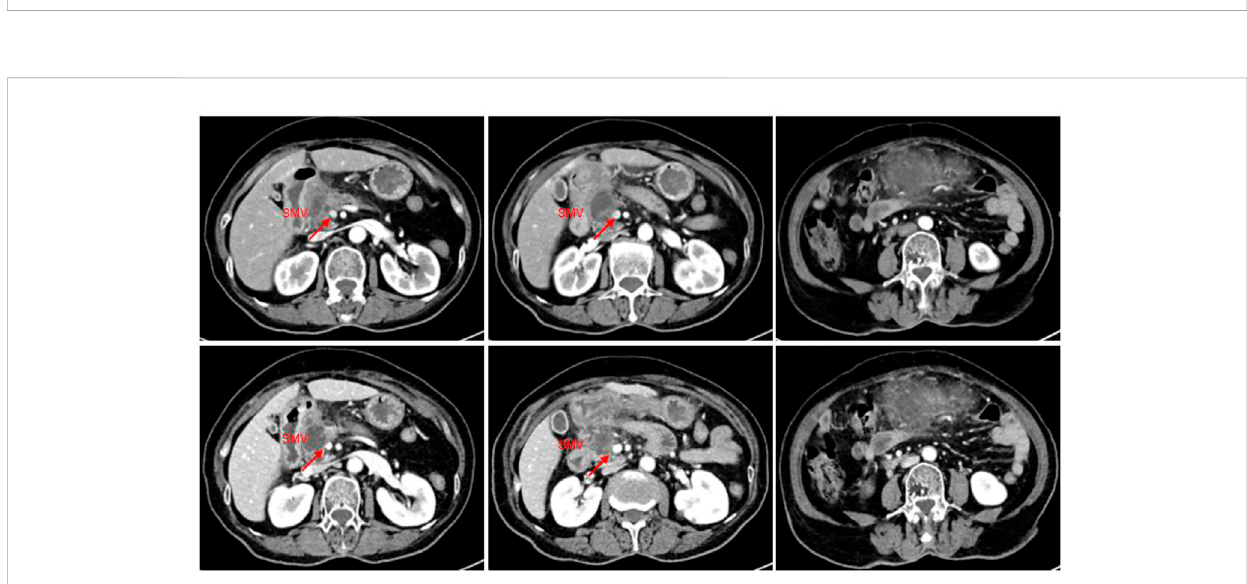
FIGURE 3 CTimagingoftheabdomen(2022.9.26):aslightlyhypodensemassofapproximately35*28 mmwithmildenhancementatthemarginwasobserved in the neck of the pancreatic head, and the right wall of the proximal end of the adjacent superior mesenteric vein was involved with a slightly narrower lumen. The tumor was 52% smaller than before